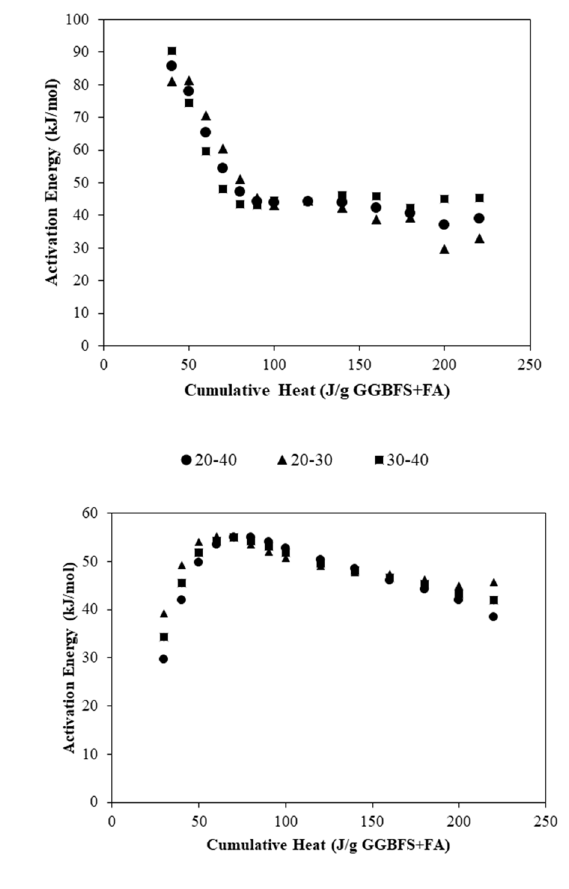
Figure 3. Evolution of apparent activation energy determined by Eq. 2 (top) and Eq. 3 (bottom).